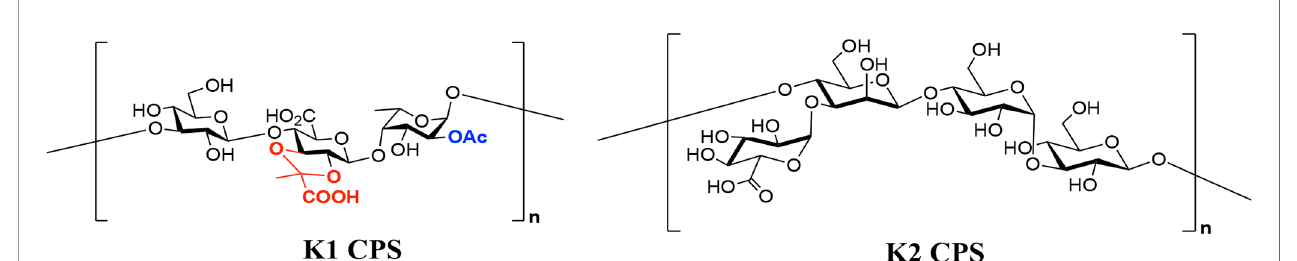
FIGURE 1 | Chemical structures of capsular polysaccharides (CPS) of K1 and